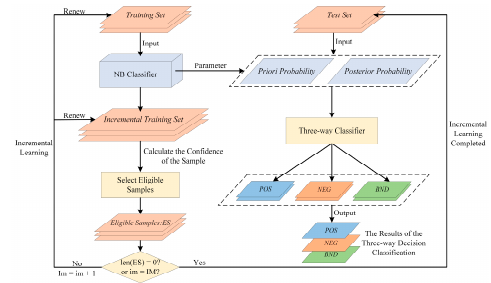
Figure 2. 3WD-IBN Algorithm Flow. The speci fi c operation of the algorithm is as follows (Algorithm 2): Algorithm 2 : 3WD-INB Classi fi cation Input : training set 𝑈={𝑥 (cid:2869) ,𝑥 (cid:2870) ,⋯,𝑥 (cid:3015) } ; incremental training set 𝐸={𝑒 (cid:2869) ,𝑒 (cid:2870) ,⋯,𝑒 (cid:3014) } ; test set 𝑇={𝑡 (cid:2869) ,𝑡 (cid:2870) ,⋯,𝑡 (cid:3017) } ; thresholds for each category (cid:3435)𝛼 (cid:3004) (cid:3278) ,𝛽 (cid:3004) (cid:3278) (cid:3439) ; maximum number of incre- ments 𝐼𝑀 ; con fi dence factor 𝛾 .